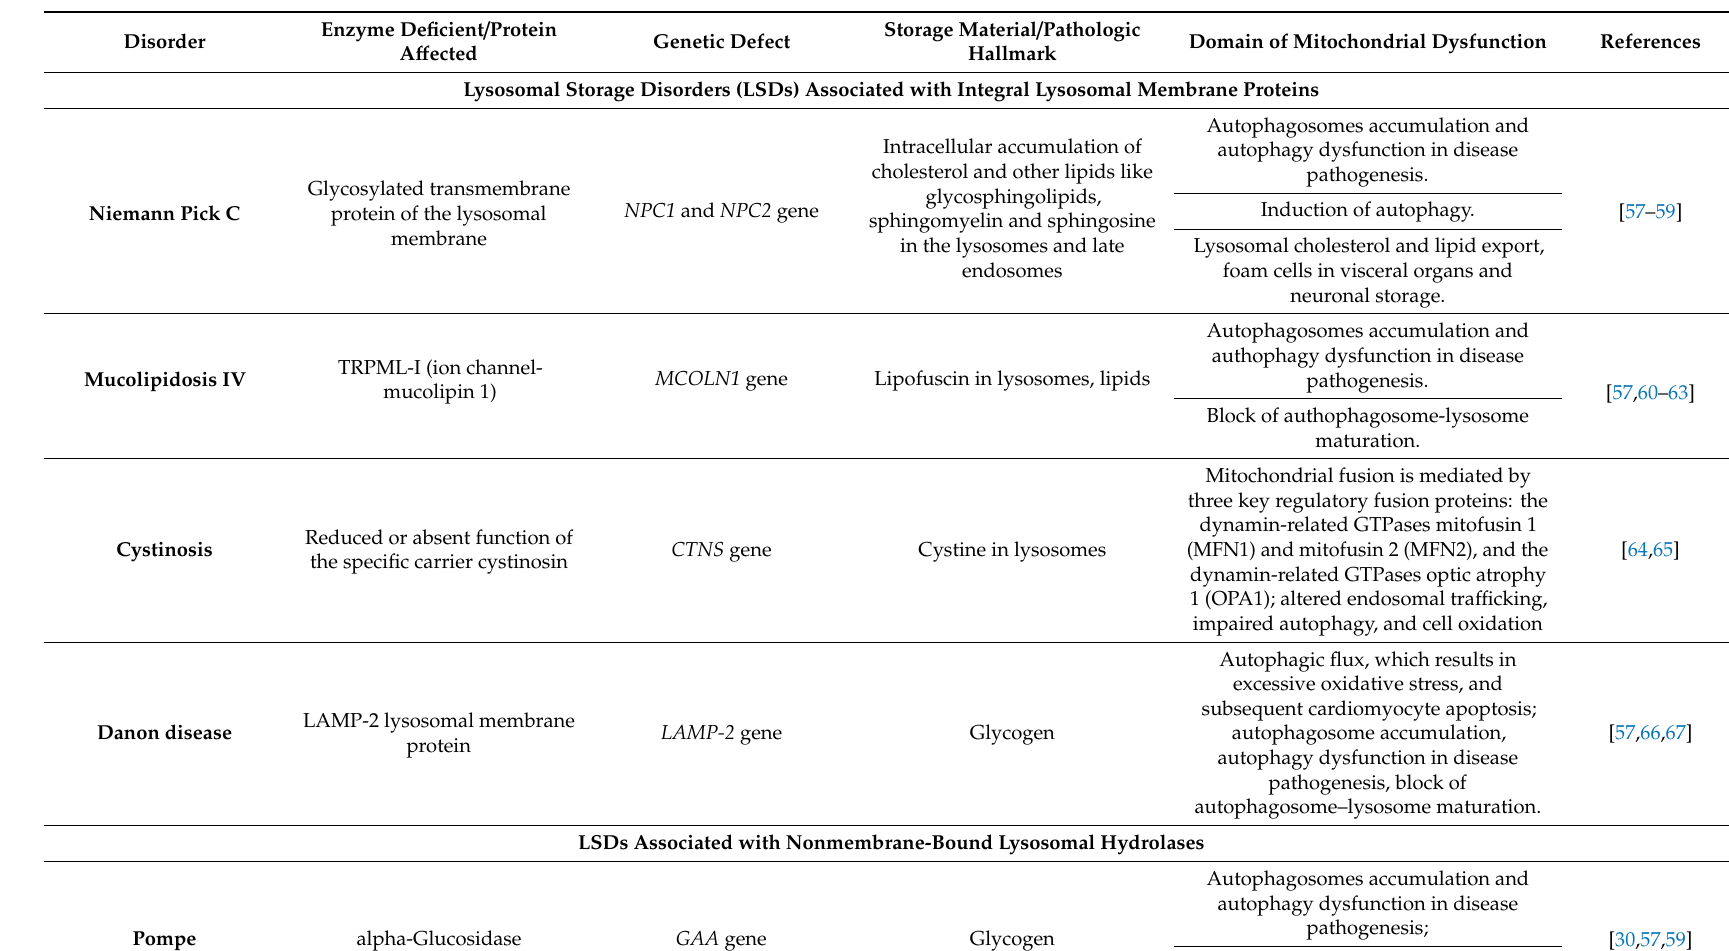
Table 1. Mitochondrial dysfunction in lysosomal storage